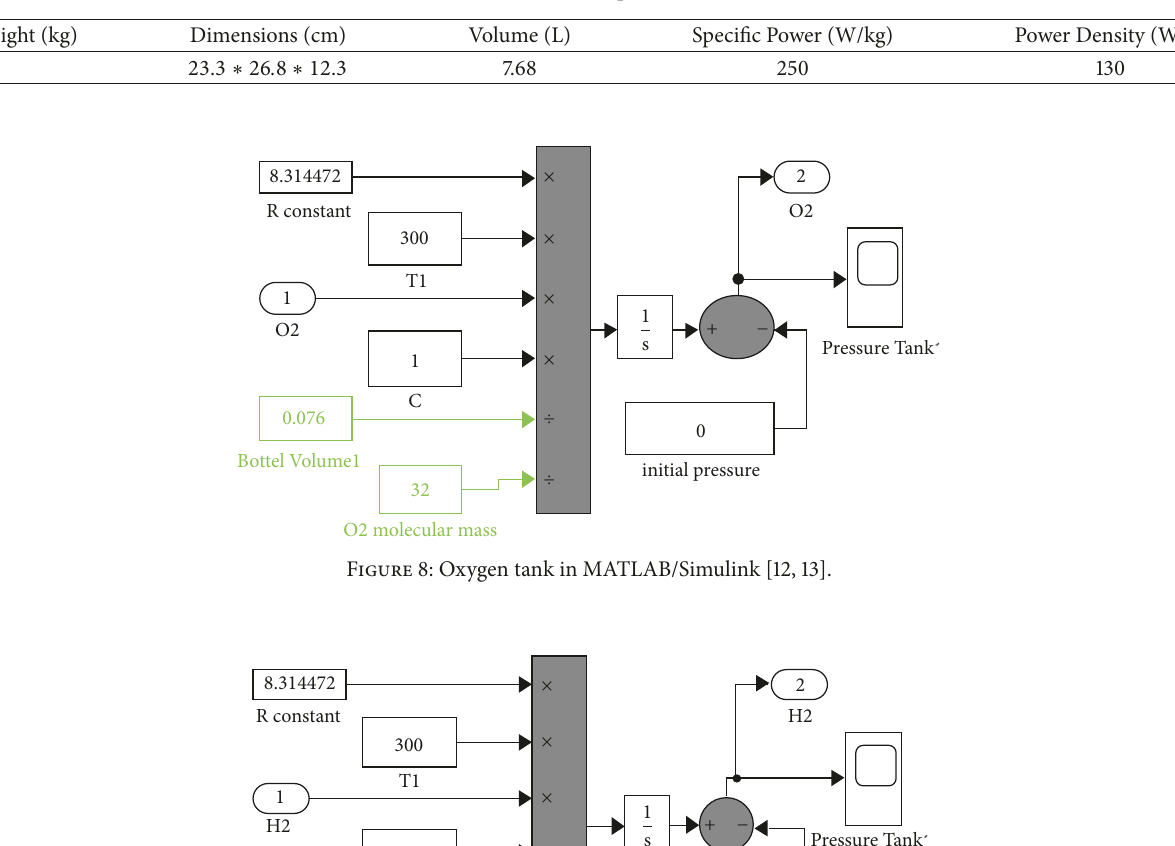
Table 3: Fuel cell parameters.